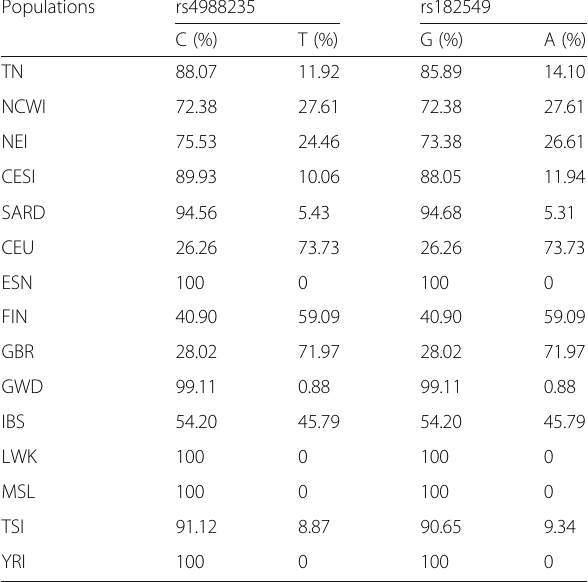
Table 1 Allelic frequencies for functional SNPs in the studied populations Populations